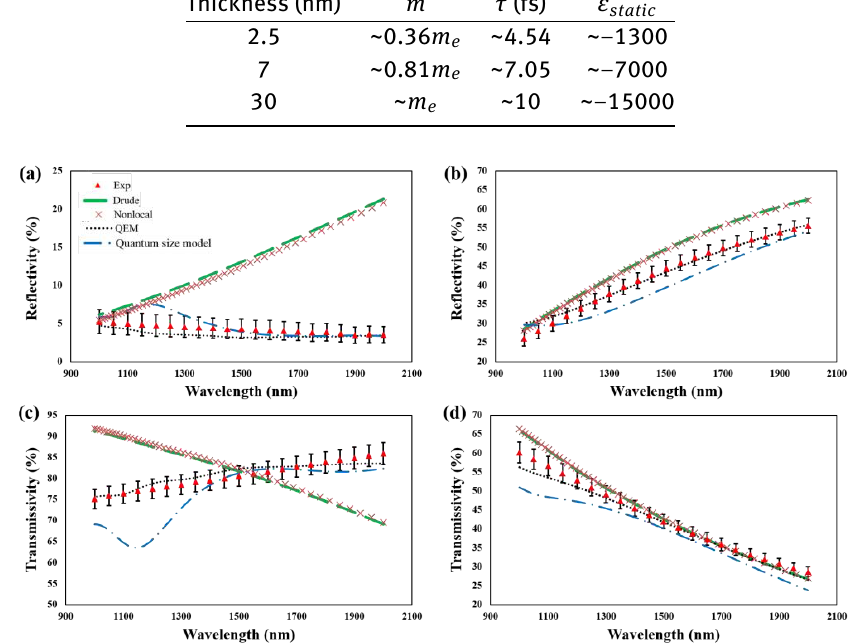
Table 1: Simulation parameters for the 2.5 nm, 7 nm, and 30 nm thick thin films.